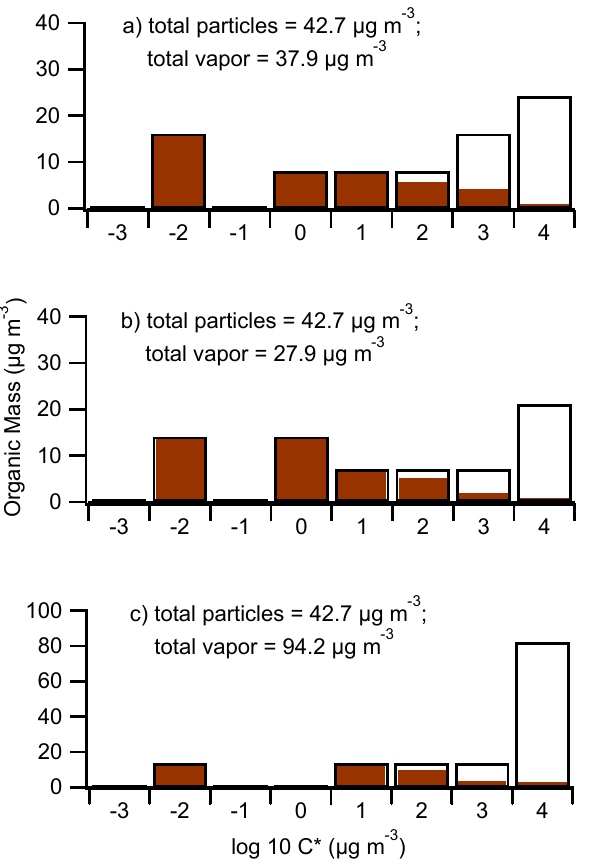
Figure 1. (a) Best-fit volatility distribution, (b) lower bound of volatility distribution and (c) upper bound of volatility distribution as reported in May et al. (2013) for a total initial average organic aerosol mass concentration of 42.7µgm − 3 over the 18 experiments. The shaded areas represent the organic mass in each volatility bin that is predicted to be in the aerosol phase, for average OC concen-